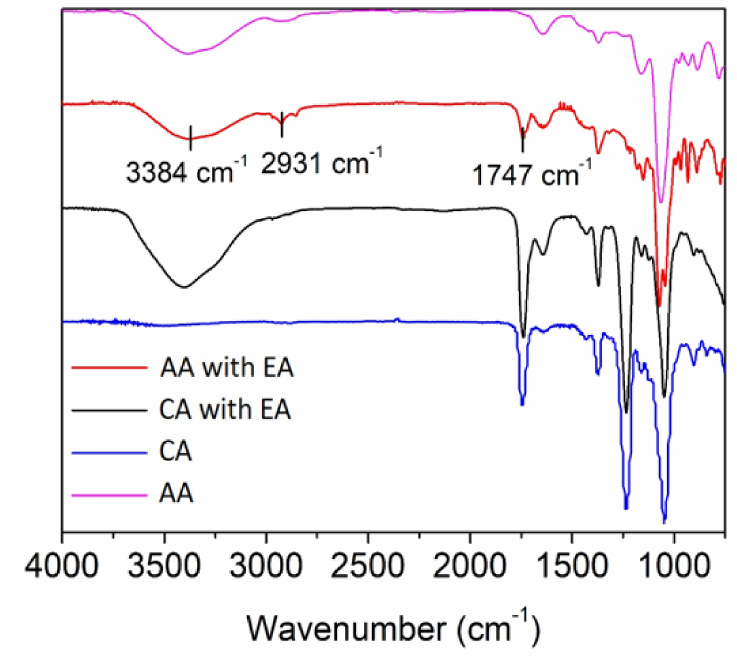
Figure 6. FT-IR spectra of AA and CA sensors, with and without